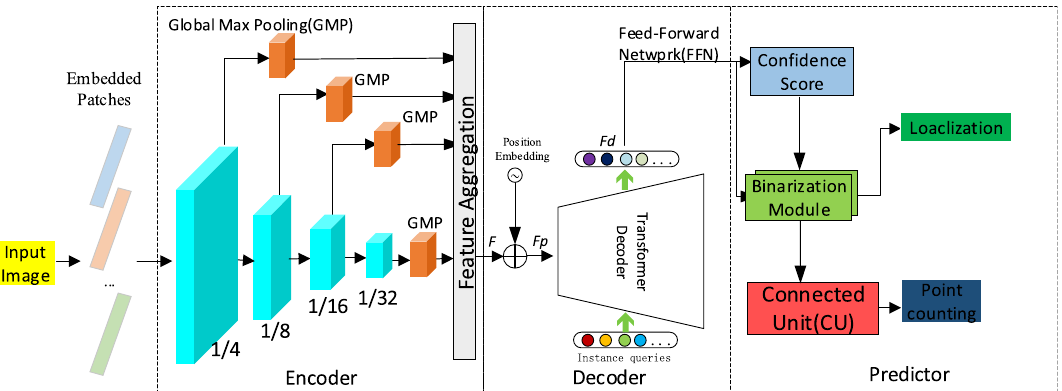
Figure 1. The Architecture of the Proposed WSITrans. The method can directly predict all instances without additional preprocessing and post-processing, including encoder, decoder, and